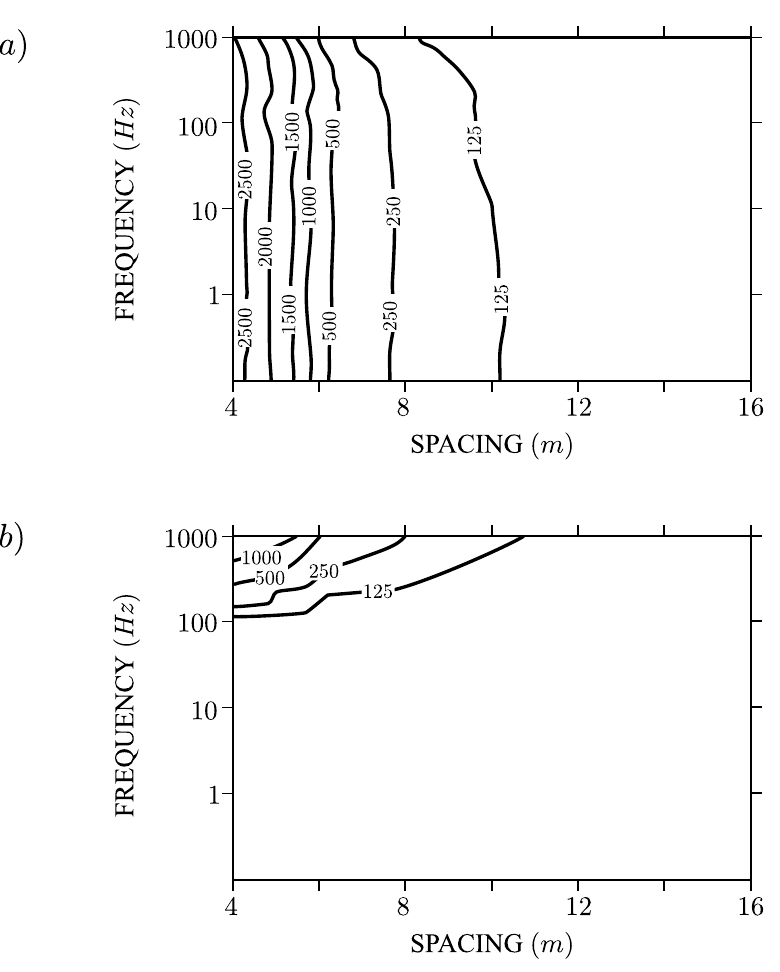
Fig. 4 –Variation of (a) the real part and (b) the imaginary part of the electric field at the sea bottom, in nV/m/mA, as a function of frequency and lateral spacing